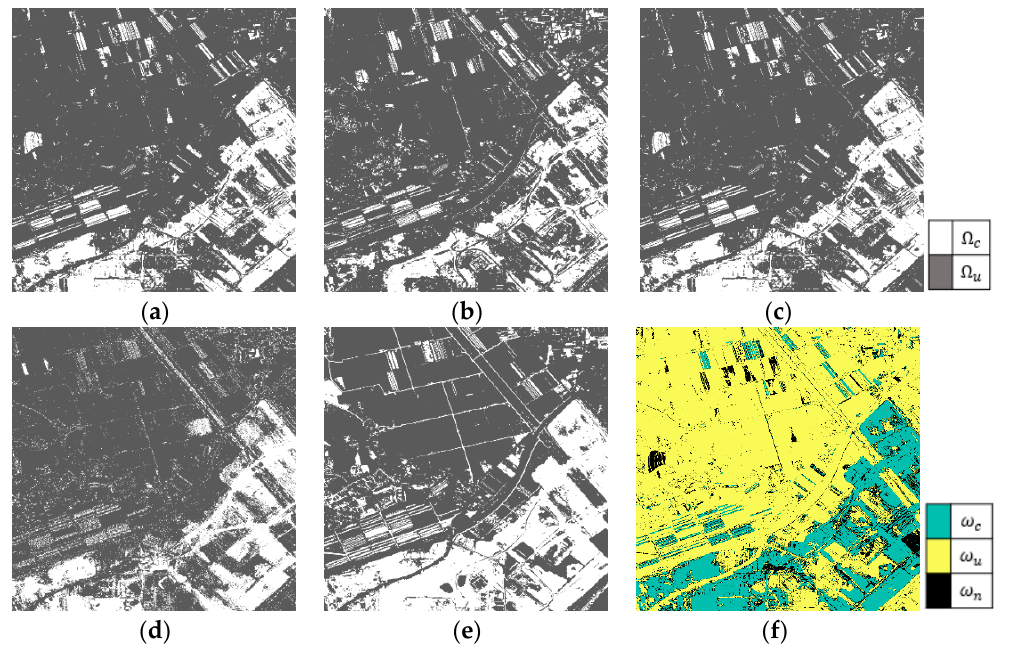
Figure 6. CD result maps of Site 1 generated using various pixel-based unsupervised CD methods: ( a ) ImageDiff ; ( b ) ImageRegr ; ( c ) CVA; ( d ) IR-MAD; ( e ) PCA; and ( f ) initial CD map. Ω c and Ω u are the change and no-change classes, respectively. ω c , ω u , and ω n are the change, no-change, and no-value classes of the initial CD map, respectively.